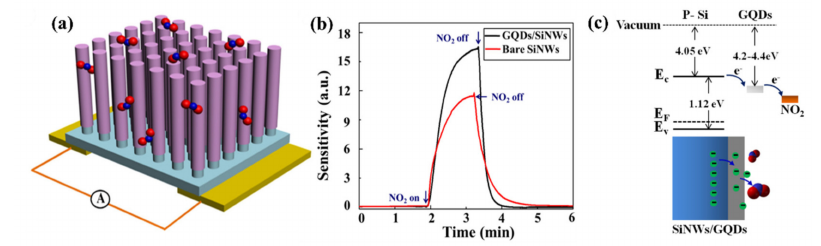
Figure 26. ( a ) Schematic diagram of the GQDs / SiNW array-based gas sensor. ( b ) Sensitivity responses of the SiNWs array with and without decoration of GQDs to NO 2 (500 ppm) at room temperature. ( c ) Energy band diagram of the GQDs / SiNW heterojunction. Reproduced from [167], with permission from IOP Publishing,